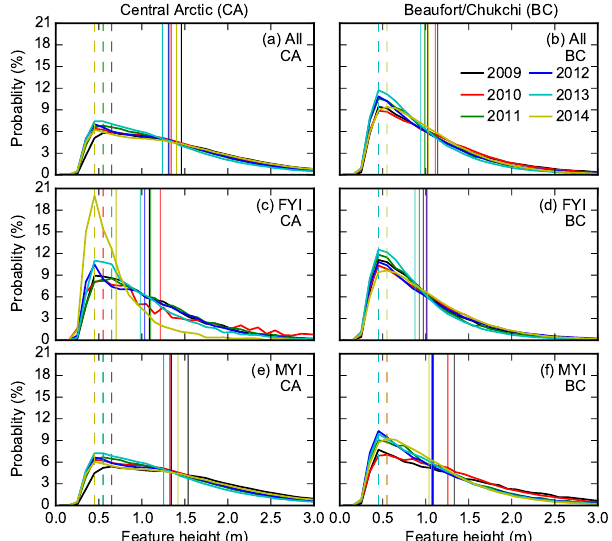
Figure 6. Probability distributions of the surface feature height, h f , (using a 20cm elevation threshold) detected within the (a) Central Arctic and (b) Beaufort/Chukchi regions (shown in Fig. 5) and for the features estimated as FYI ( c and d ) or MYI ( e and f ) using the OSI-SAF ice type mask described in Sect. 3. The bin width is 10cm and the bin values are plotted as lines (joining each value) instead of steps for clarity. The solid (dashed) vertical lines show the mean (mode) of the distributions across each year. The statistics (mean, mode and standard deviation) are summarized in Table 2.